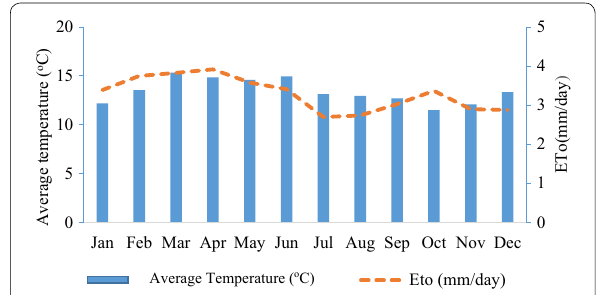
Fig. 6 Mean monthly temperature and evapotranspiration